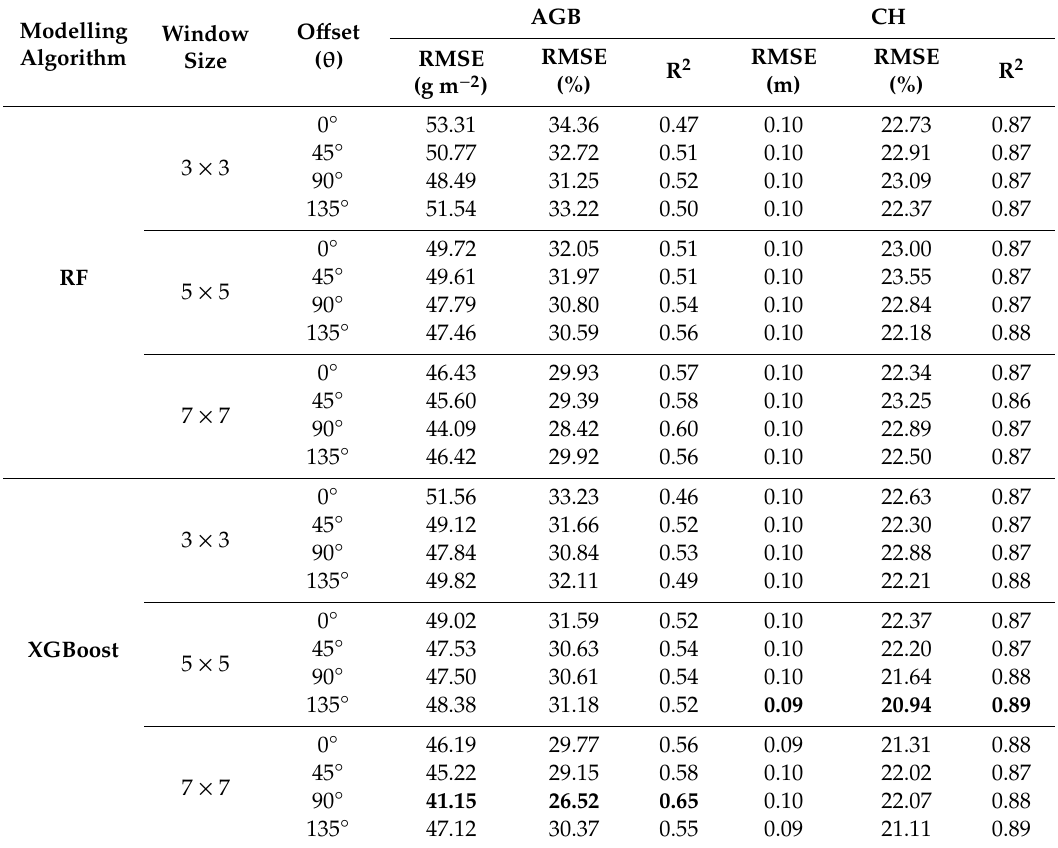
Table 4. Performance of PlanetScope-derived texture measures in predicting pasture aboveground biomass (AGB) and canopy height (CH) using the random forest (RF) and extreme gradient boosting (XGBoost) regression algorithms based on the testing dataset. The optimum combination of texture parameters are highlighted in